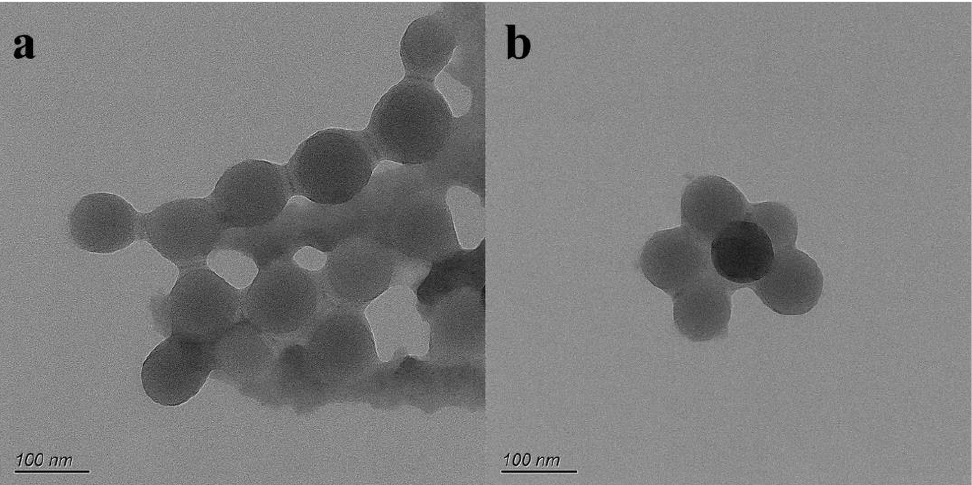
Figure 5. TEM images of modified nanoscale titania coating diluted with deionized water: ( a ) dilute 10 times, ( b ) dilute 20 times.